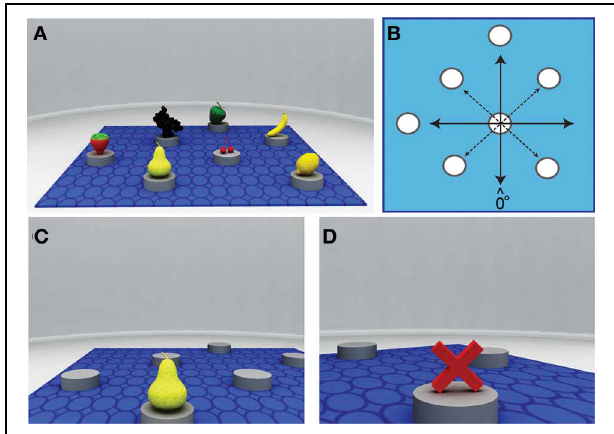
FIGURE 1 | Schematic and local views of the virtual arena used during the learning phase. (A) Survey view of the arena showing the object array and the square mat (in blue) that provided the extrinsic frame of reference. (B) The spatial arrangement of objects in the array (white circles). Inter-object relationships are thought to be encoded preferentially with respect to coordinates aligned with the sides of the square mat (solid lines), as opposed to misaligned (dashed lines). (C) In Experiment 1B, when participants arrived at a correct location, the probed target object (e.g., a pear) appeared immediately above the placeholder. (D) When participants arrived at an incorrect location, a red cross appeared above the